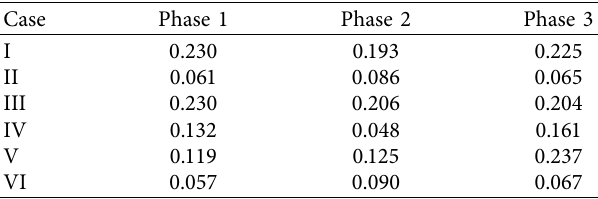
Table 3: Te active power generation of the distribution substation